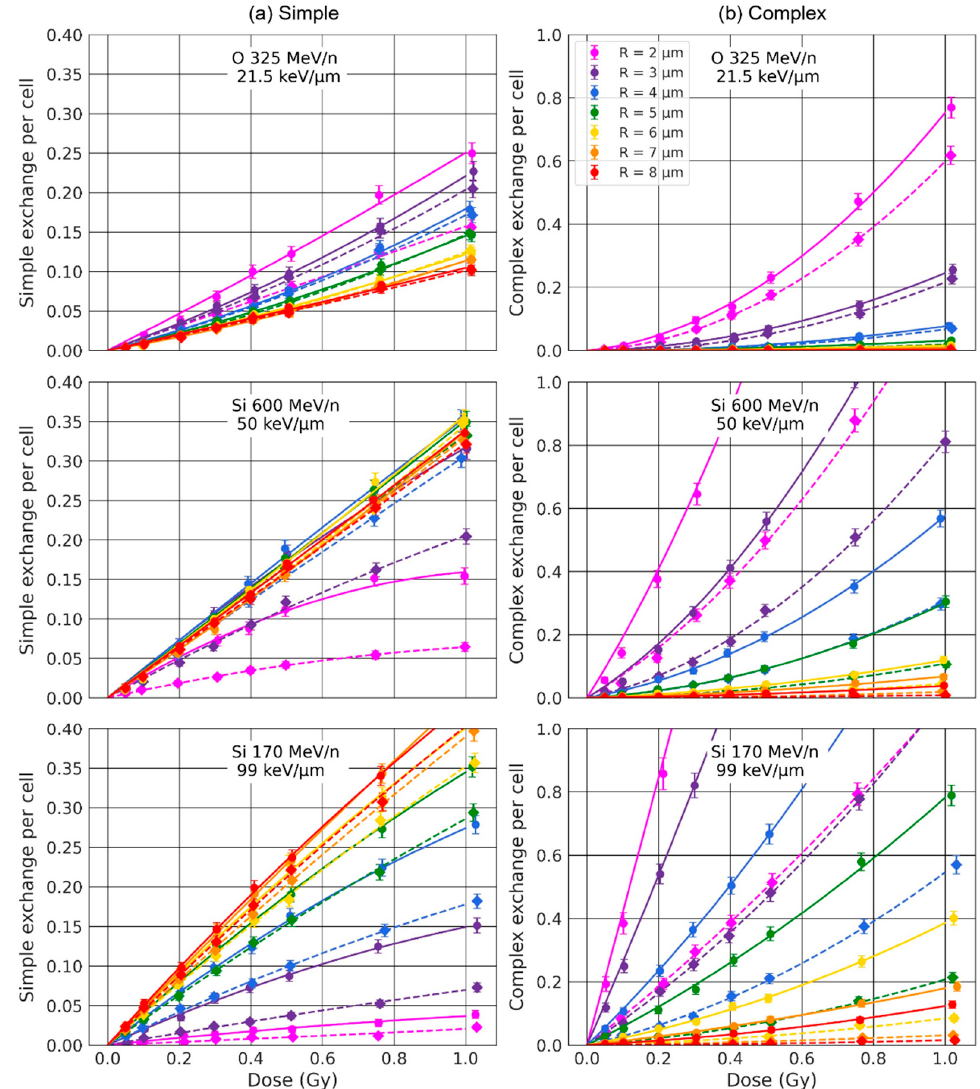
Figure 4. Dose-response of simple ( a ) and complex ( b ) exchanges for 3 ion beams and spherical nuclei of radii varying from 2 μ m to 8 μ m. The data points are calculated by RITCARD. The lines represent the best linear quadric fit of the dose-response. Solid line with round symbols: without chromosome domain constraint. Dashed line with diamond symbols: with chromosome domain constraint.